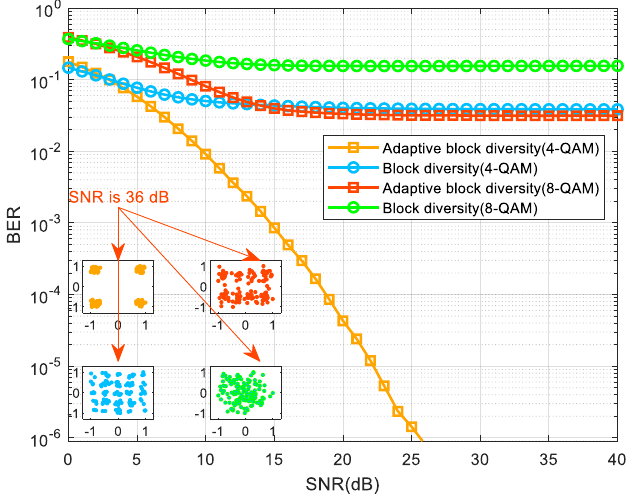
Figure 10. BER performance under link misalignment error of 23 mm.